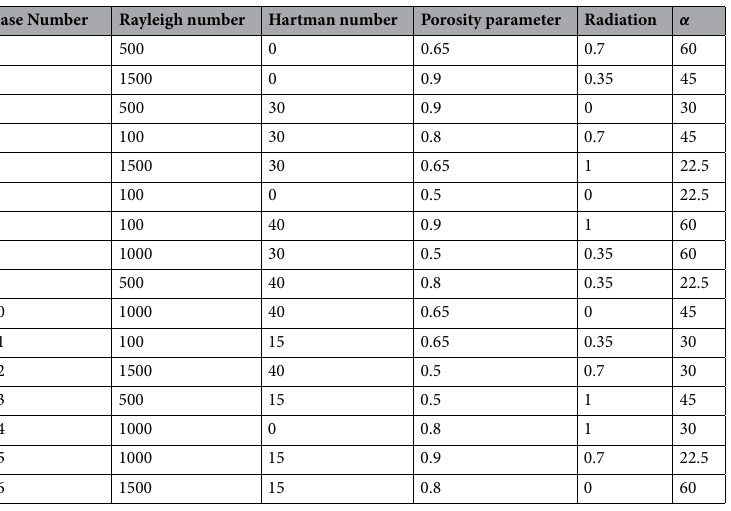
Table 2. Planned tests by Taguchi